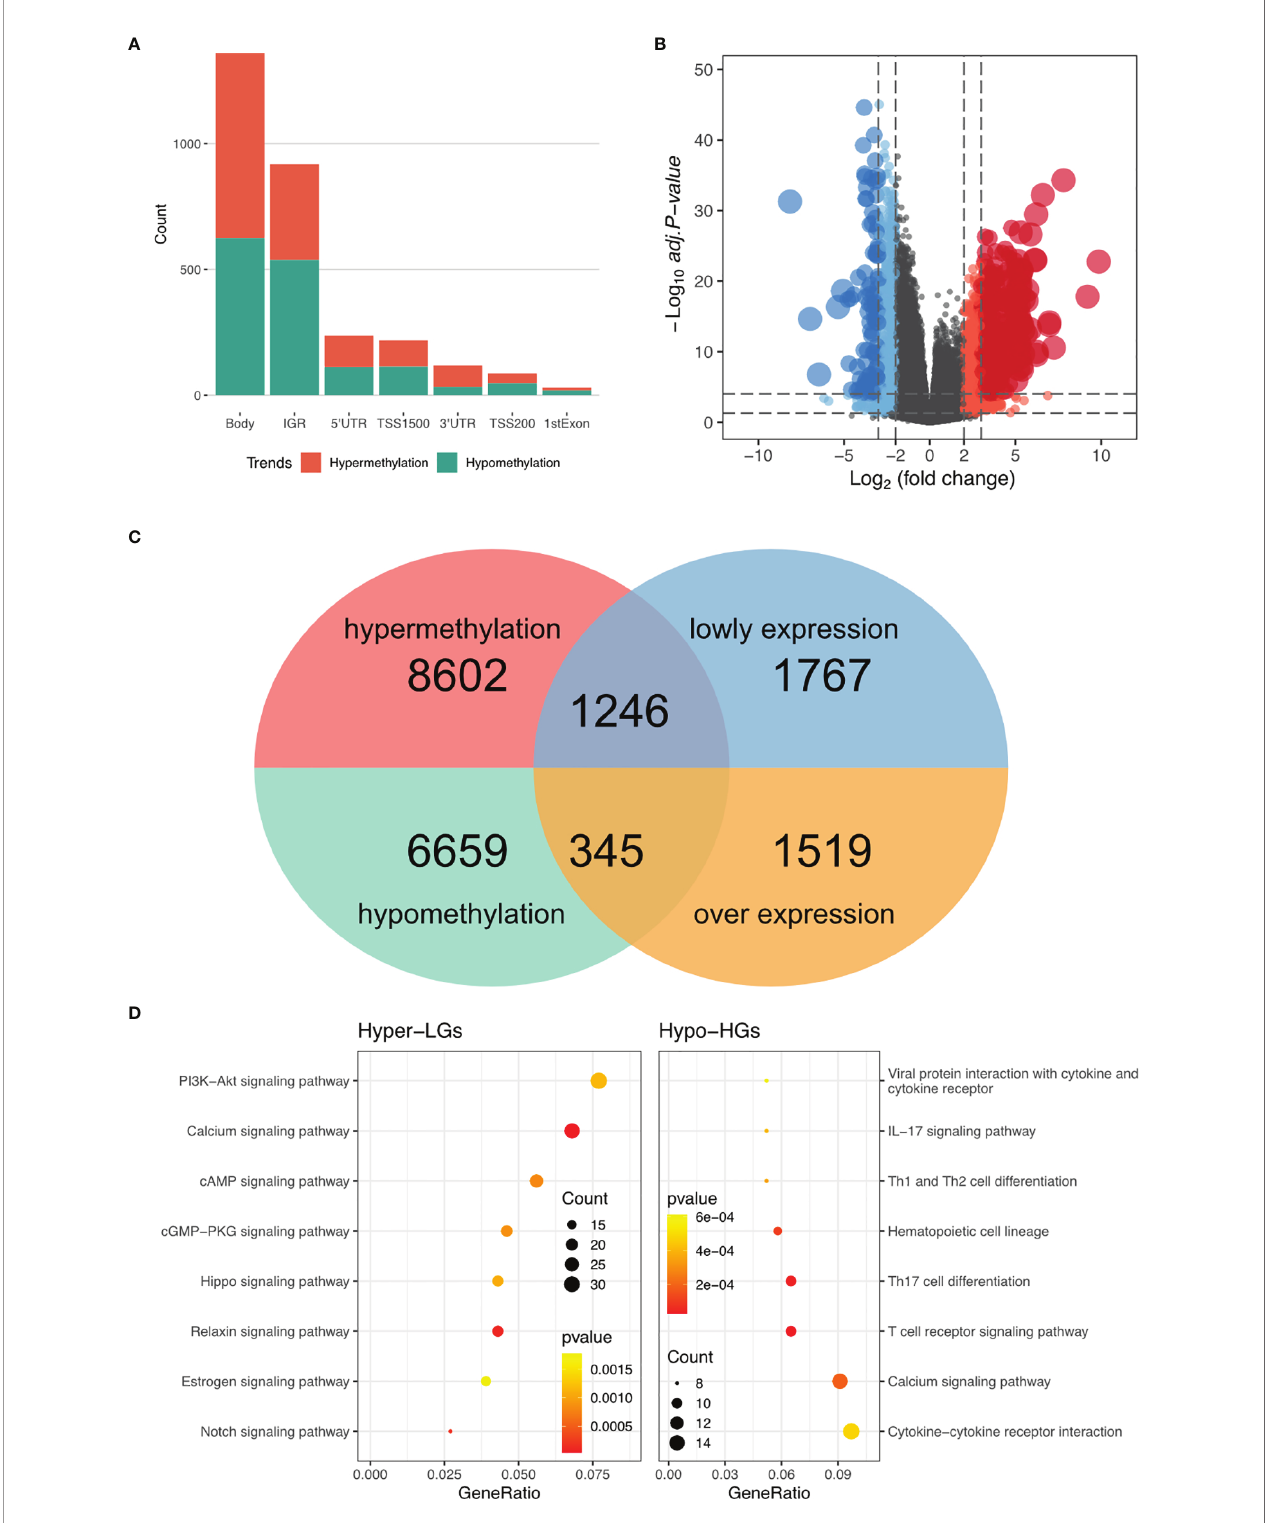
FIGURE 1 | DNA methylation regulatory network in RA. (A) Statistic of the genomic location of differentially methylated sites. (B) Volcano plot for RNA-seq differential expression analysis. (C) Screening of hypermethylated-low expression genes (Hyper-LGs) and highly-expressed genes (Hypo-HGs). (D) Kyoto Encyclopedia of Genes and Genomes pathway enrichment analysis of Hyper-LGs and